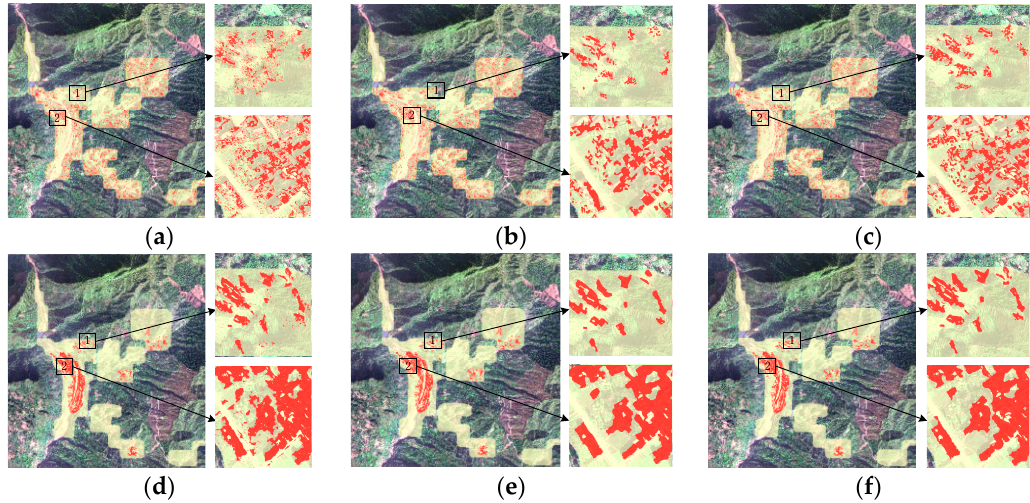
Figure 13. Building results of the spectral-based methods using the Pléiades image: ( a ) K means _MS_Pix; ( b ) K means _MS_MV; ( c ) K means _MS_Seg; ( d ) SVM_MS_Pix; ( e ) SVM_MS_MV; and ( f ) SVM_MS_Seg.